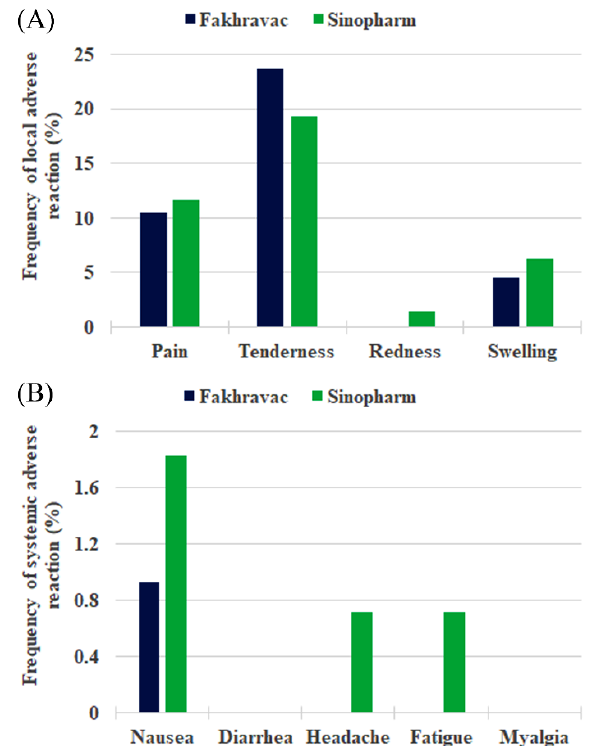
Figure 1. Percentage of participants with adverse reactions within 14 days of vaccines post-injection. ( A , B ) represent the percentage of “local” and “systemic” adverse reactions, respectively .